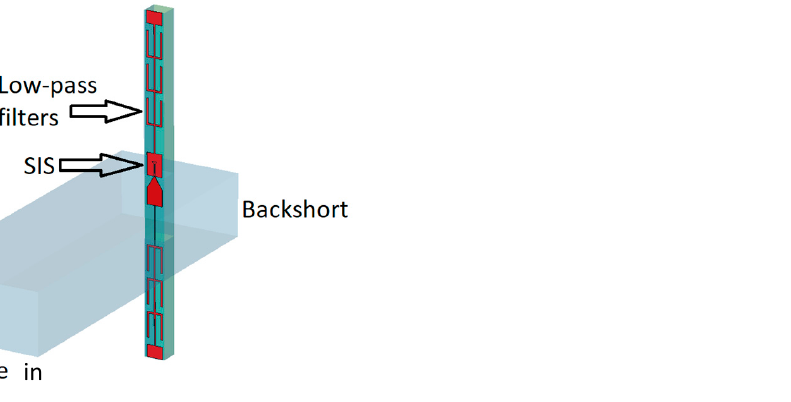
Figure 5. A 3D model for a double-side mixer placed inside a waveguide channel. The input horn is placed in the front side of the waveguide mixer block (Waveguide in), and the back short position is marked in a back view.